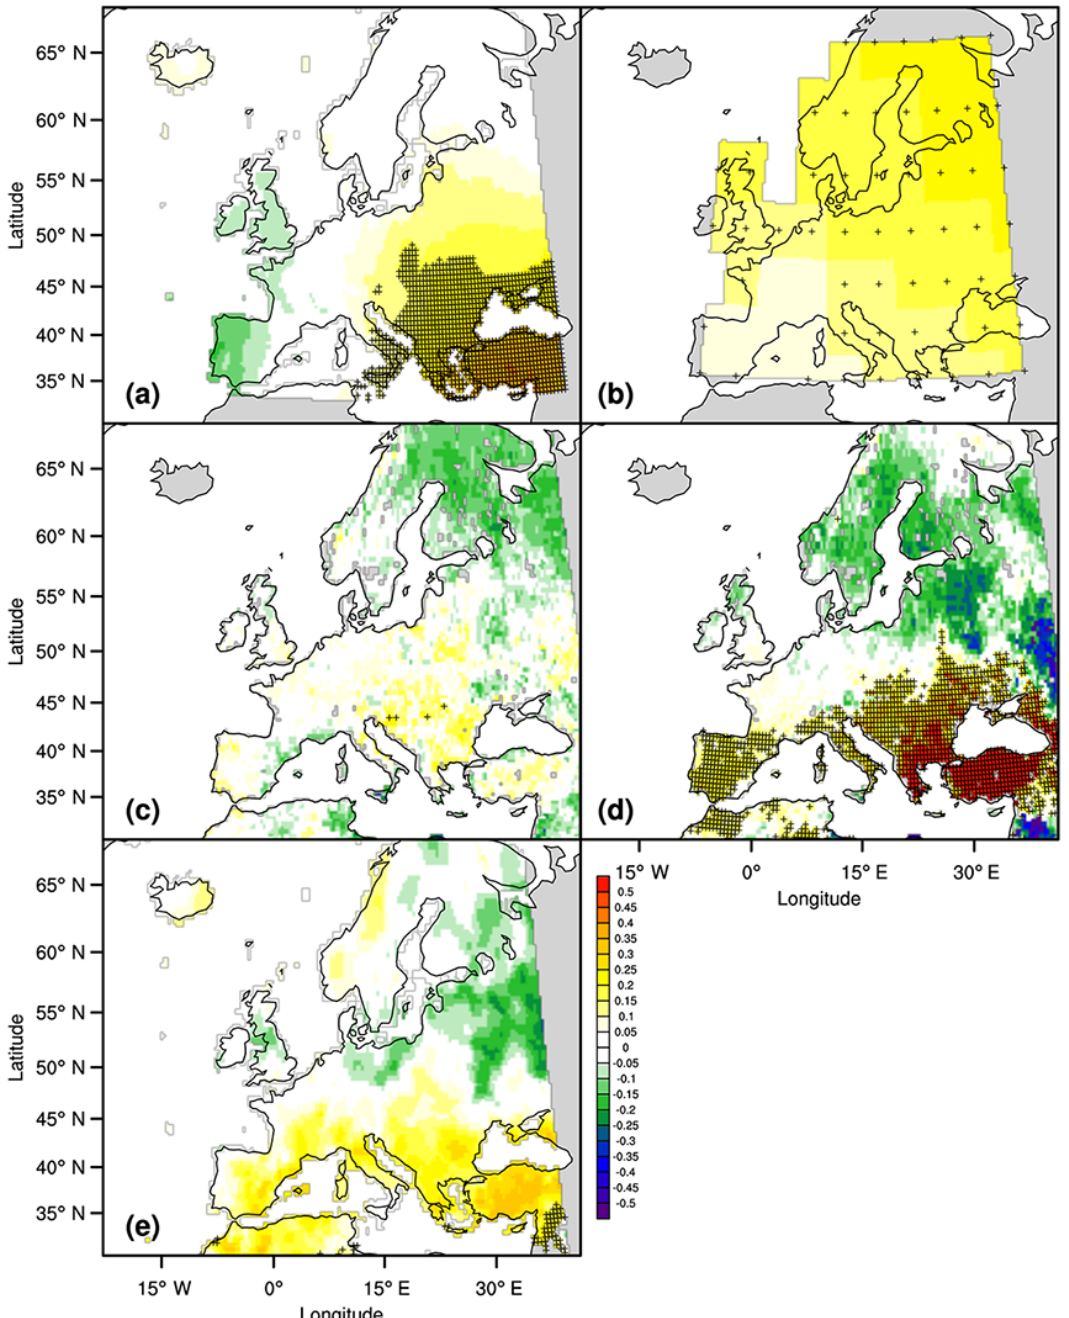
Figure 8. Spatial correlation maps for the March–April temperature reconstruction and precipitation signal (PC 1 ) obtained from the tree-ring dataset during the period 1800–2002 over Europe. Maps demonstrate spatial field correlations between our temperature reconstruction and (a) gridded spring temperature reconstruction for Europe (Xoplaki et al., 2005), (b) gridded summer temperature reconstruction for Europe (Luterbacher et al., 2016), (c) Old World Drought Atlas (OWDA; Cook et al., 2015). Panels (d) and (e) show spatial correlations between PC 1 and OWDA (Cook et al., 2015) and gridded European summer precipitation reconstruction (Pauling et al., 2006), respectively. The + sign represents significant correlation coefficients ( p